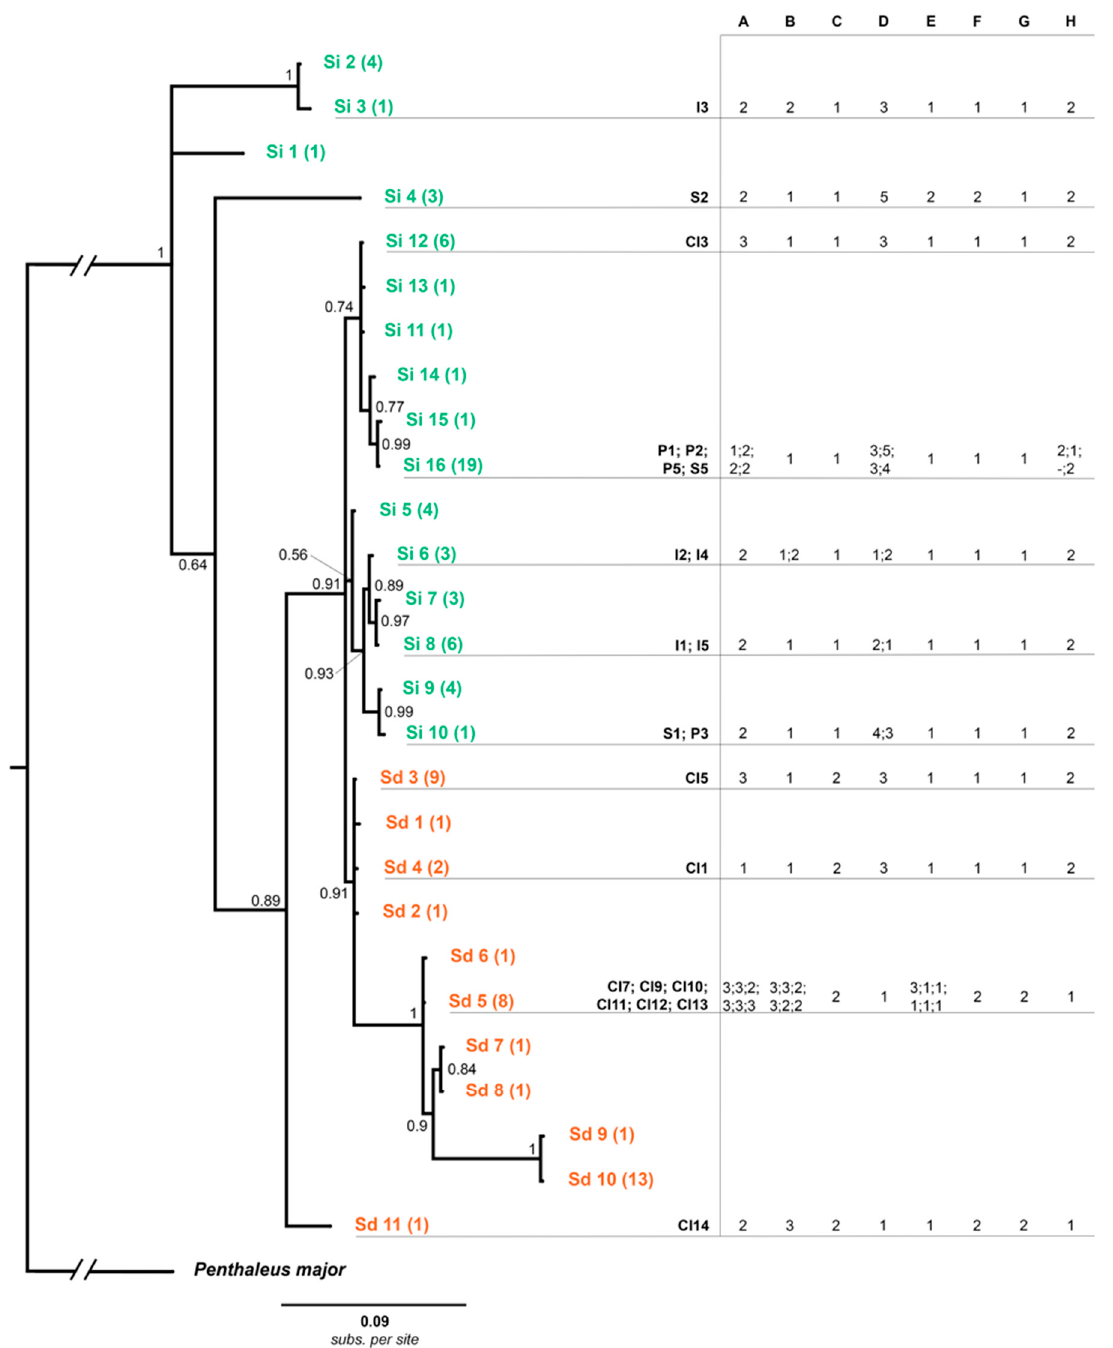
Figure 6. Phylogenetic tree of the combined mitochondrial and nuclear sequences of S. delicatus (orange labels) and S. ineffabilis (green labels) and table with codes of the morphological characters (see Table 8). Posterior probabilities are shown at the nodes of the phylogenetic tree. For the specimen ID (black, bold), see Table 2.